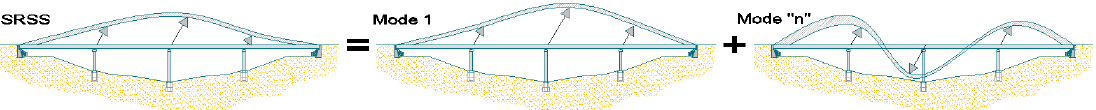
Figure 3. Application of the Square Root of the Sum of Squares rule to a bridge.